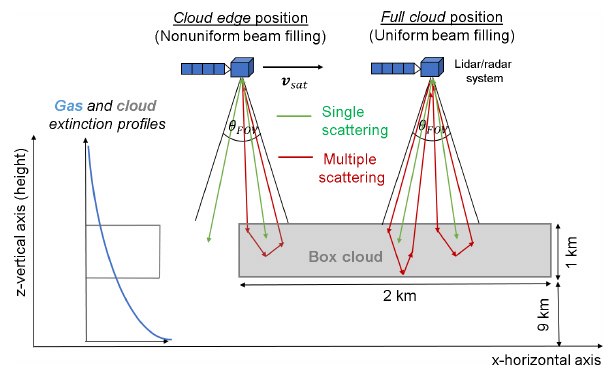
Figure 6. Schematic representation of two specific positions of a spaceborne lidar–radar system relative to the idealized box cloud. The box-cloud base altitude is 9km, its geometrical thickness is 1km, and its x -horizontal and y -horizontal extension is 2km and in- finite, respectively. The cloud vertical extinction profile is constant. In the two positions, single- and multiple-scattering photon path ex- amples are represented by green and red arrows,